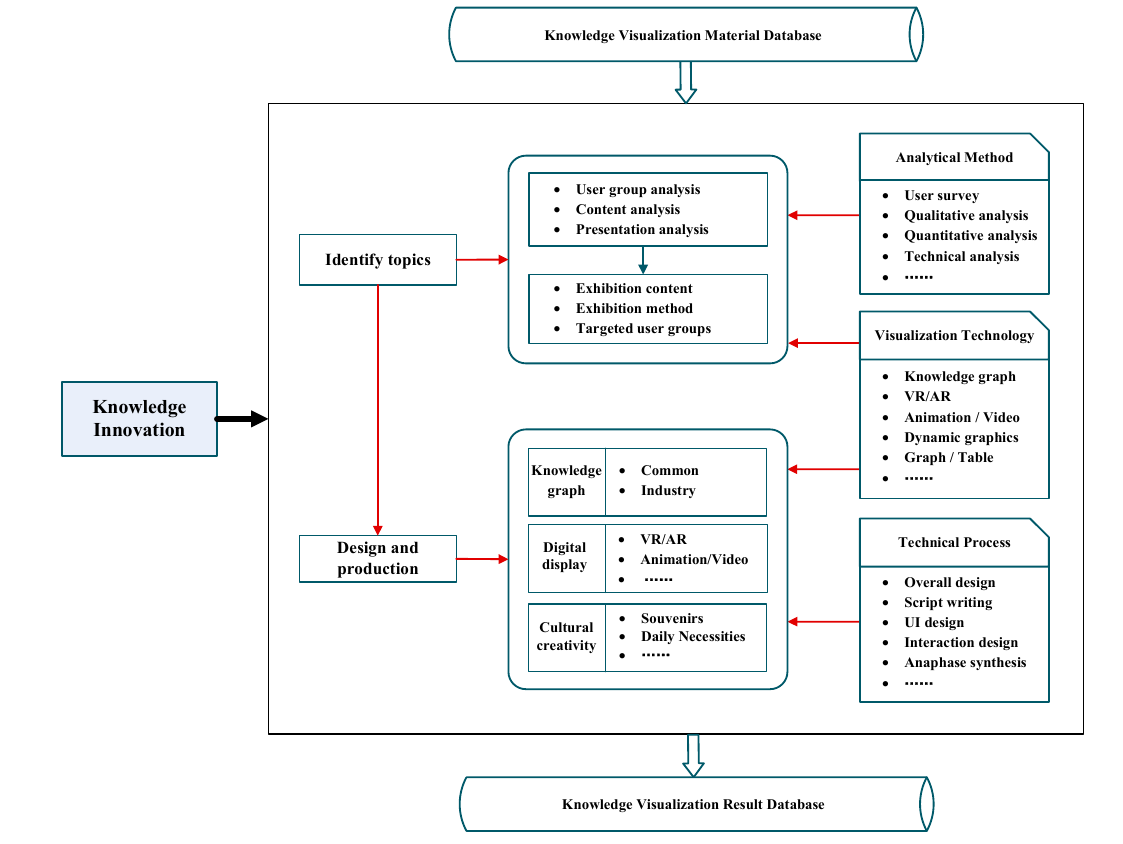
Figure 4. Technical framework of the knowledge